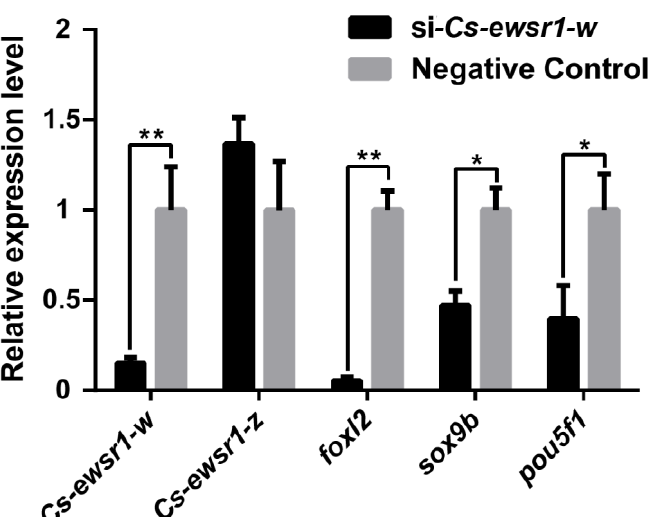
Figure 8. The knockdown effect of Cs-ewsr1-w siRNA in C. semilaevis ovarian cells. The relative expression variations of Cs-ewsr1-z , Forkhead Box L2 ( foxl2 ), SRY-box transcription factor 9b ( sox9b ), POU Class 5 Homeobox 1 ( pou5f1 ) were measured. An asterisk (*) indicates a significant difference between negative control group and siRNA-treated group ( p < 0.05). Two asterisks (**) indicates an extremely significant difference ( p < 0.01).